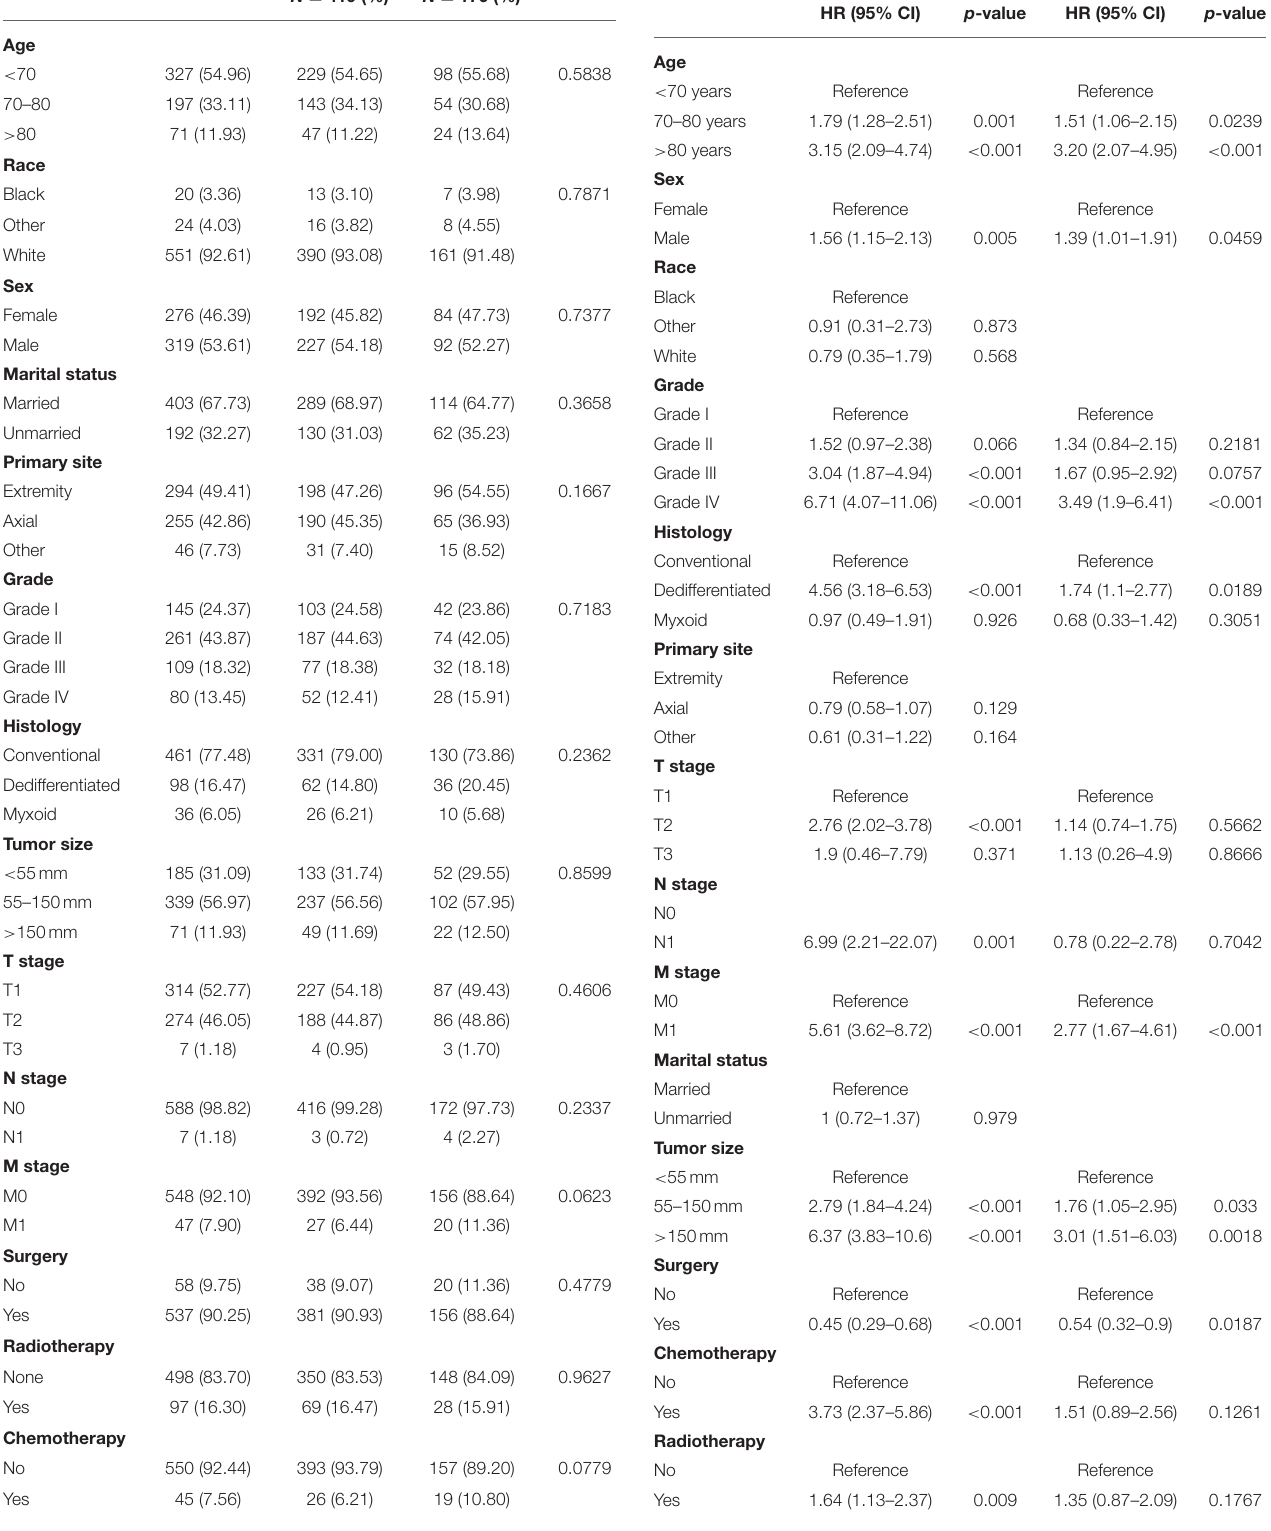
TABLE 1 | Clinicopathological characteristics of elderly patients with CHS. TABLE 2 | Univariate and multivariate Cox proportional hazards regression analysis of the OS of elderly patients with CHS. Variables Univariate analysis Multivariate